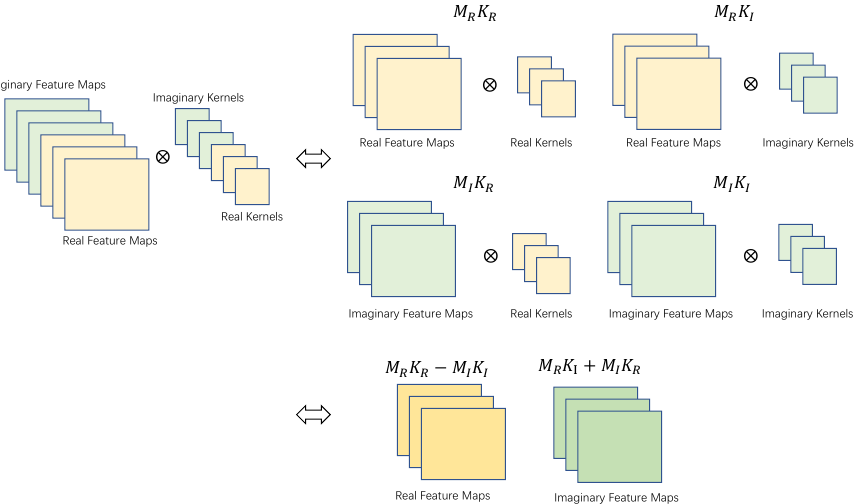
Figure 1. Convolutional layer calculation process of complex-valued CNN.